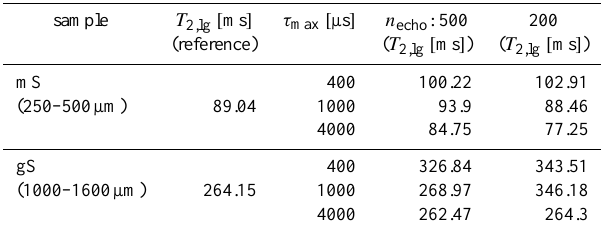
Table 4. Logarithmic mean decay time T 2,lg for all CPMG se- quences conducted on samples granular material. The second column denotes T 2,lg of the reference sequence conducted with n echo =5000 and a constant τ